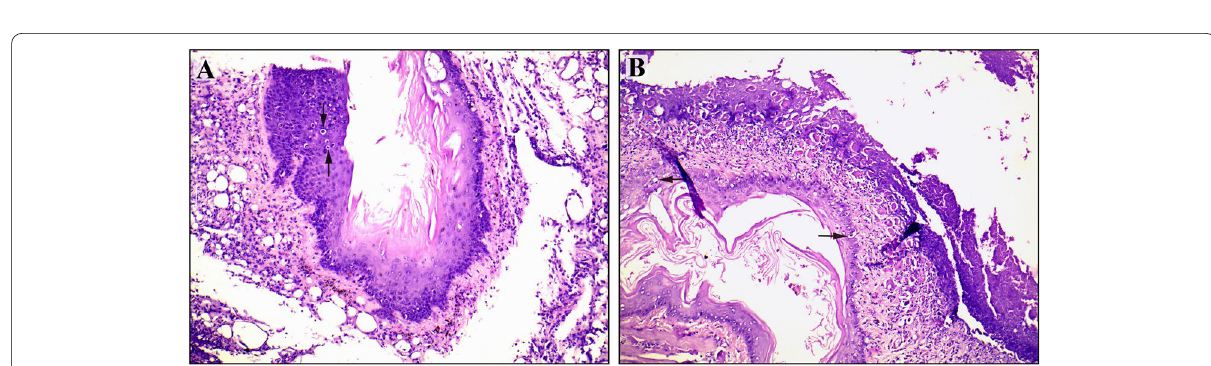
Fig. 4 A photomicrograph showing apoptotic malignant epithelium cells (arrows) with condensed nucleus and clearance of cytoplasm at 21 weeks of DMBA and genistein administration, group 2B (H&E ×